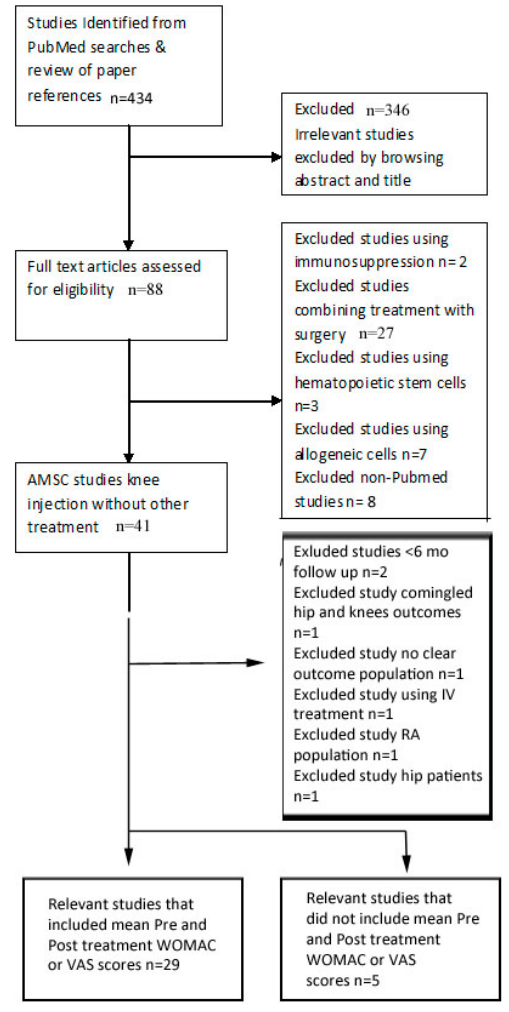
Figure 1. Flow diagram—study selection process.